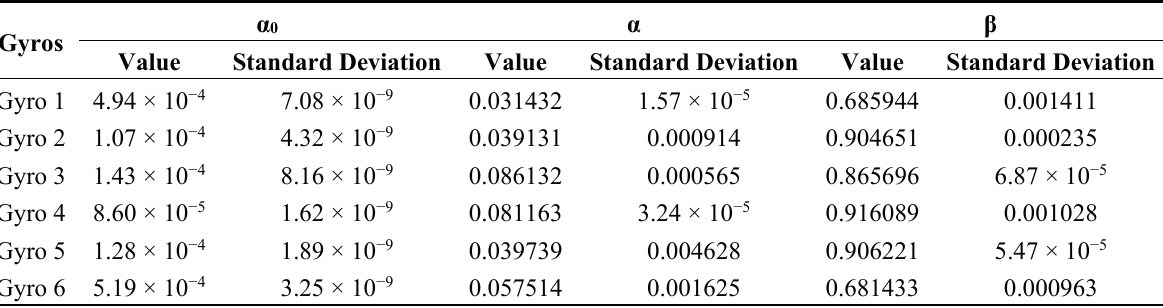
Table 2. Estimated results of Generalized Autoregressive Conditional Heteroskedasticity (GARCH) (1, 1).